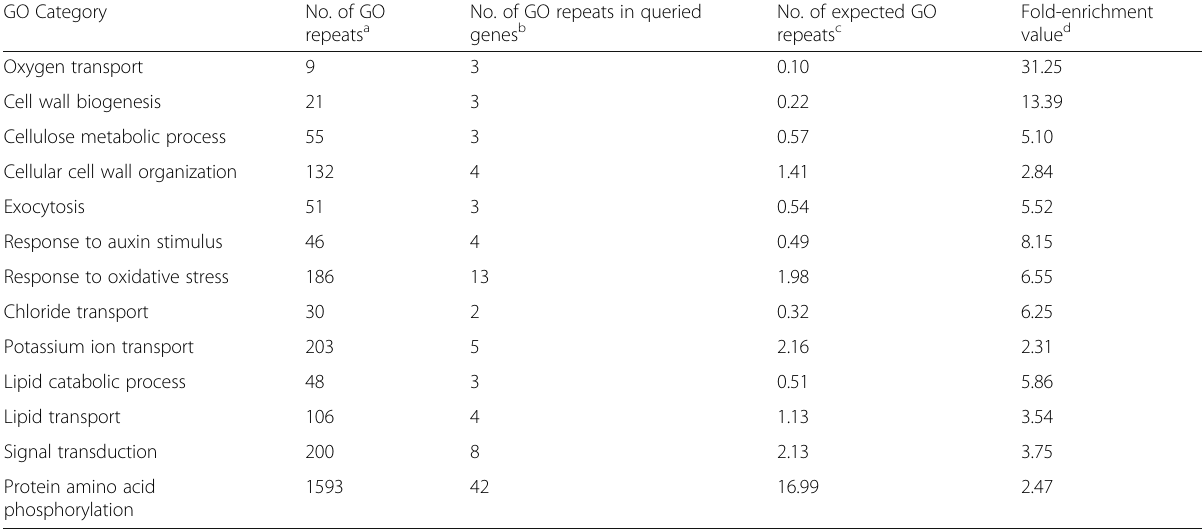
Table 1 Analysis of significantly enriched Gene Ontology terms for root hair-preferential genes from rice GO